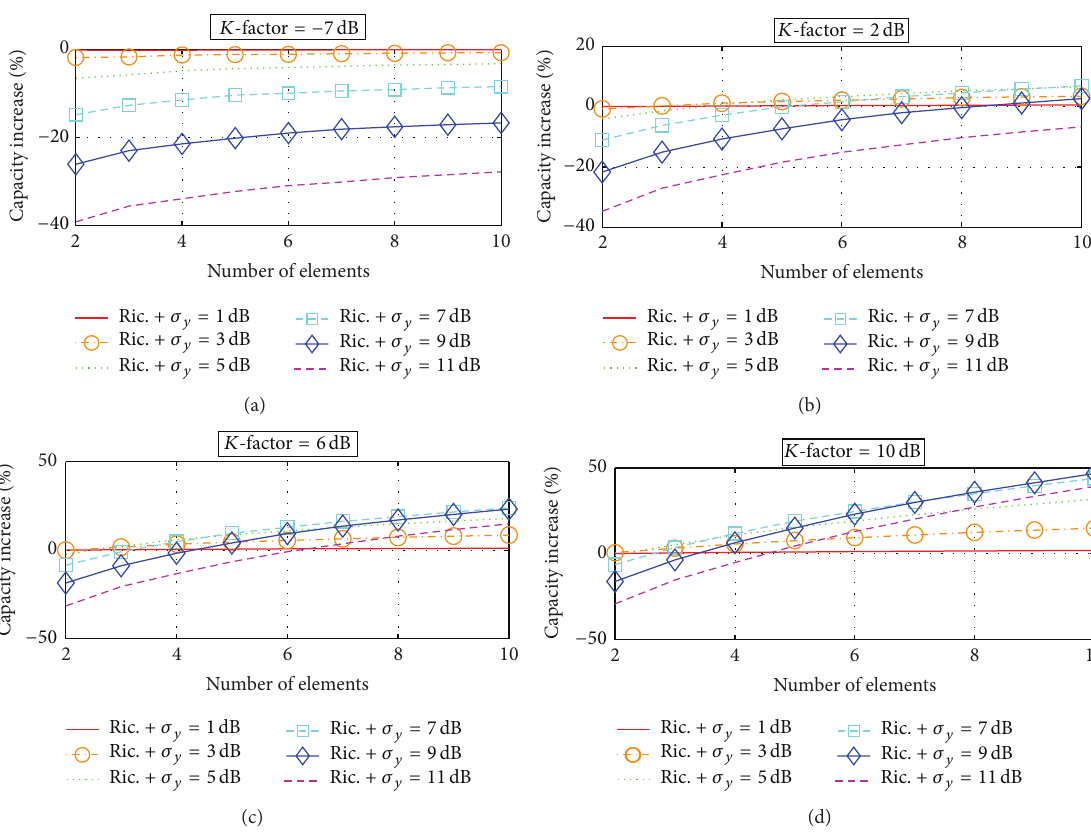
Figure 12: Capacity increase versus the number of elements, with shadowing as parameter and for different 𝐾 -factor, (a) 𝐾 = −7 dB, (b) 𝐾 = 2 dB, (c) 𝐾 = 6 dB, and (d) 𝐾 = 10 dB.